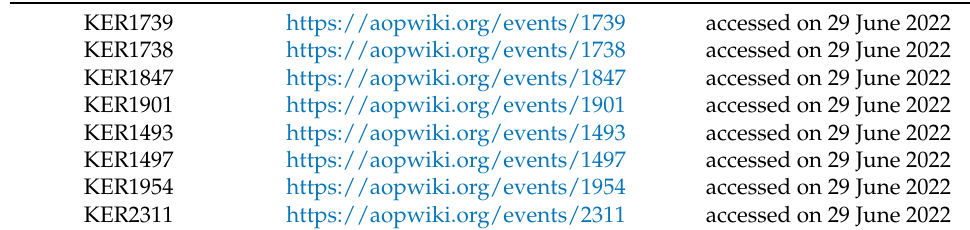
Table 1. AOP-wiki